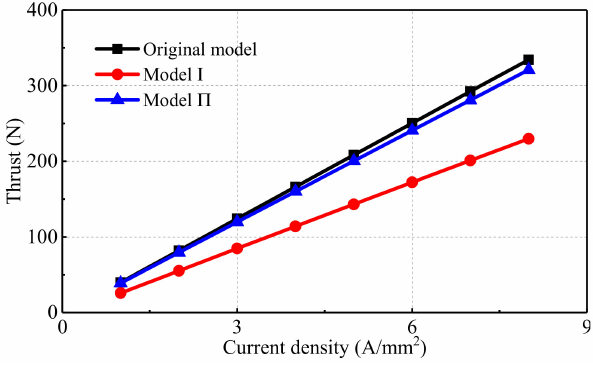
Figure 19. Thrust versus current density.